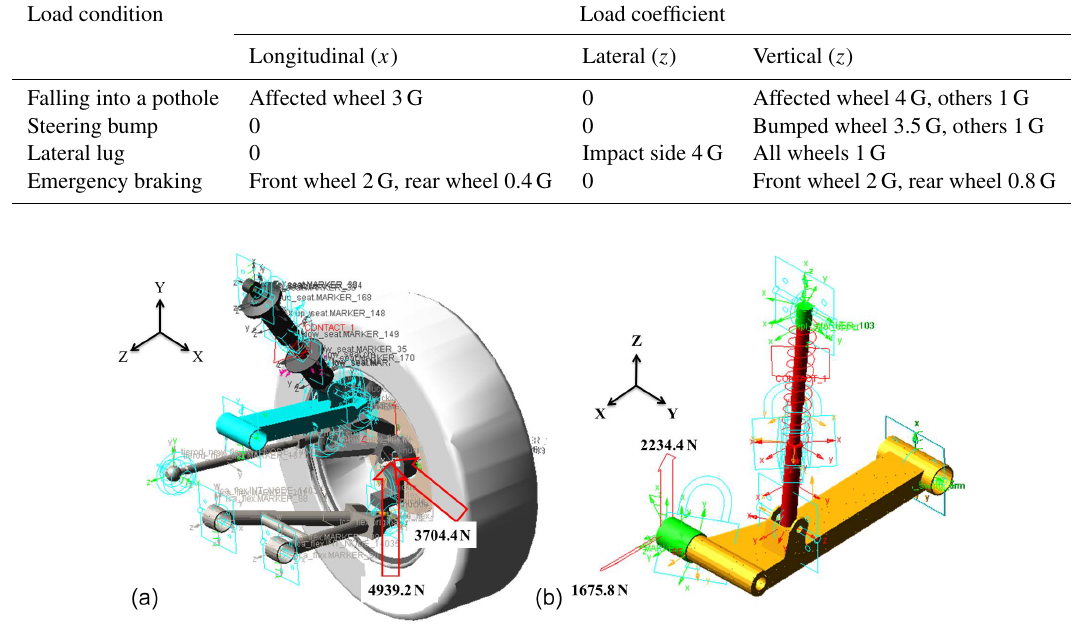
Figure 9. Mechanical kinematics models of: (a) front suspension, and (b) rear suspension.